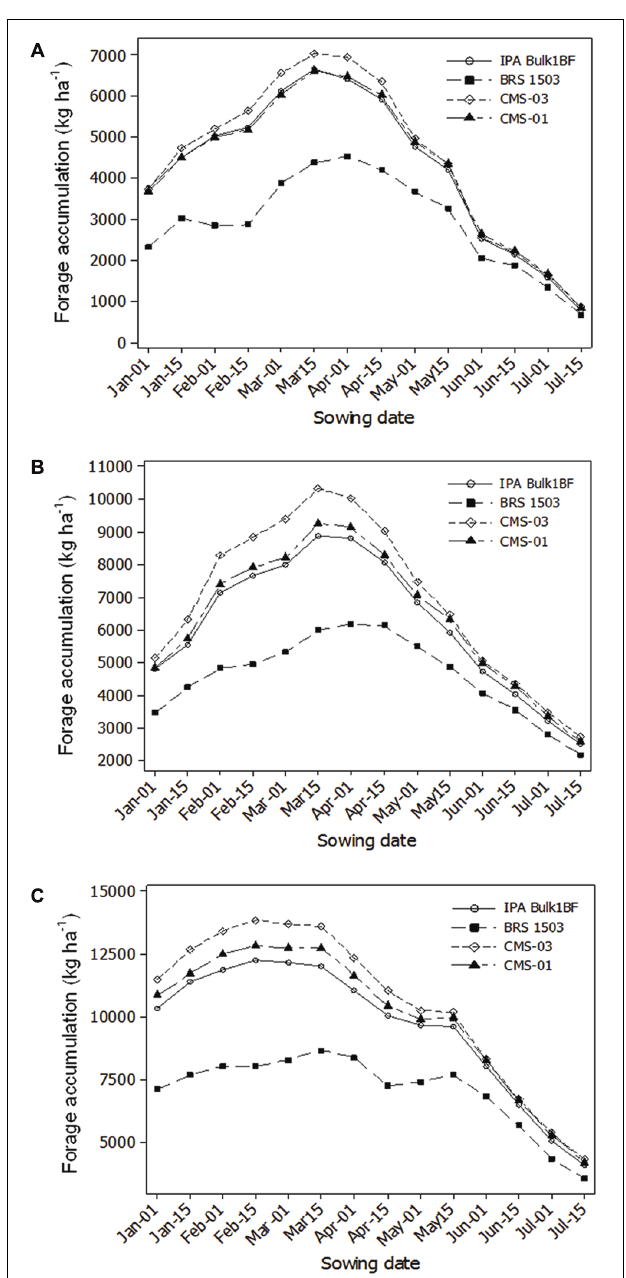
FIGURE 2 | Simulated pearl millet forage accumulation for different cultivars at different sowing dates for Bom Conselho (A) , Nossa Senhora da Gloria (B) , and Sao Bento do Una (C)